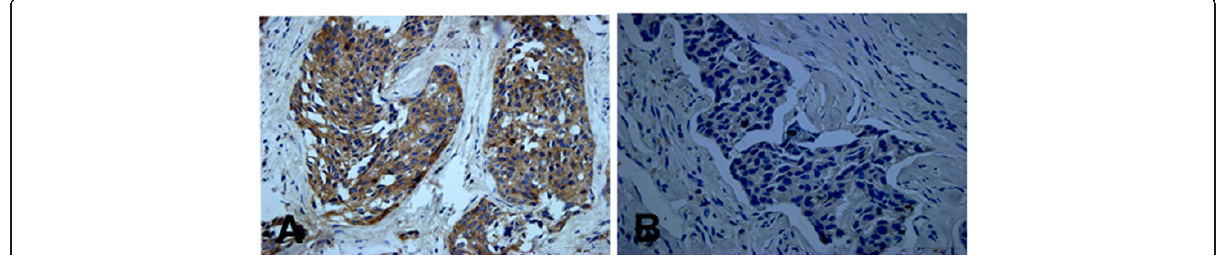
Figure 1 Expression and location of ASK1 in breast invasive ductal carcinoma (IDC) (Original magnification × 400). ( A ) ASK1 positive staining was predominant in the cytoplasm of breast carcinoma tissues. ( B ) ASK1 negative staining was seen in IDC